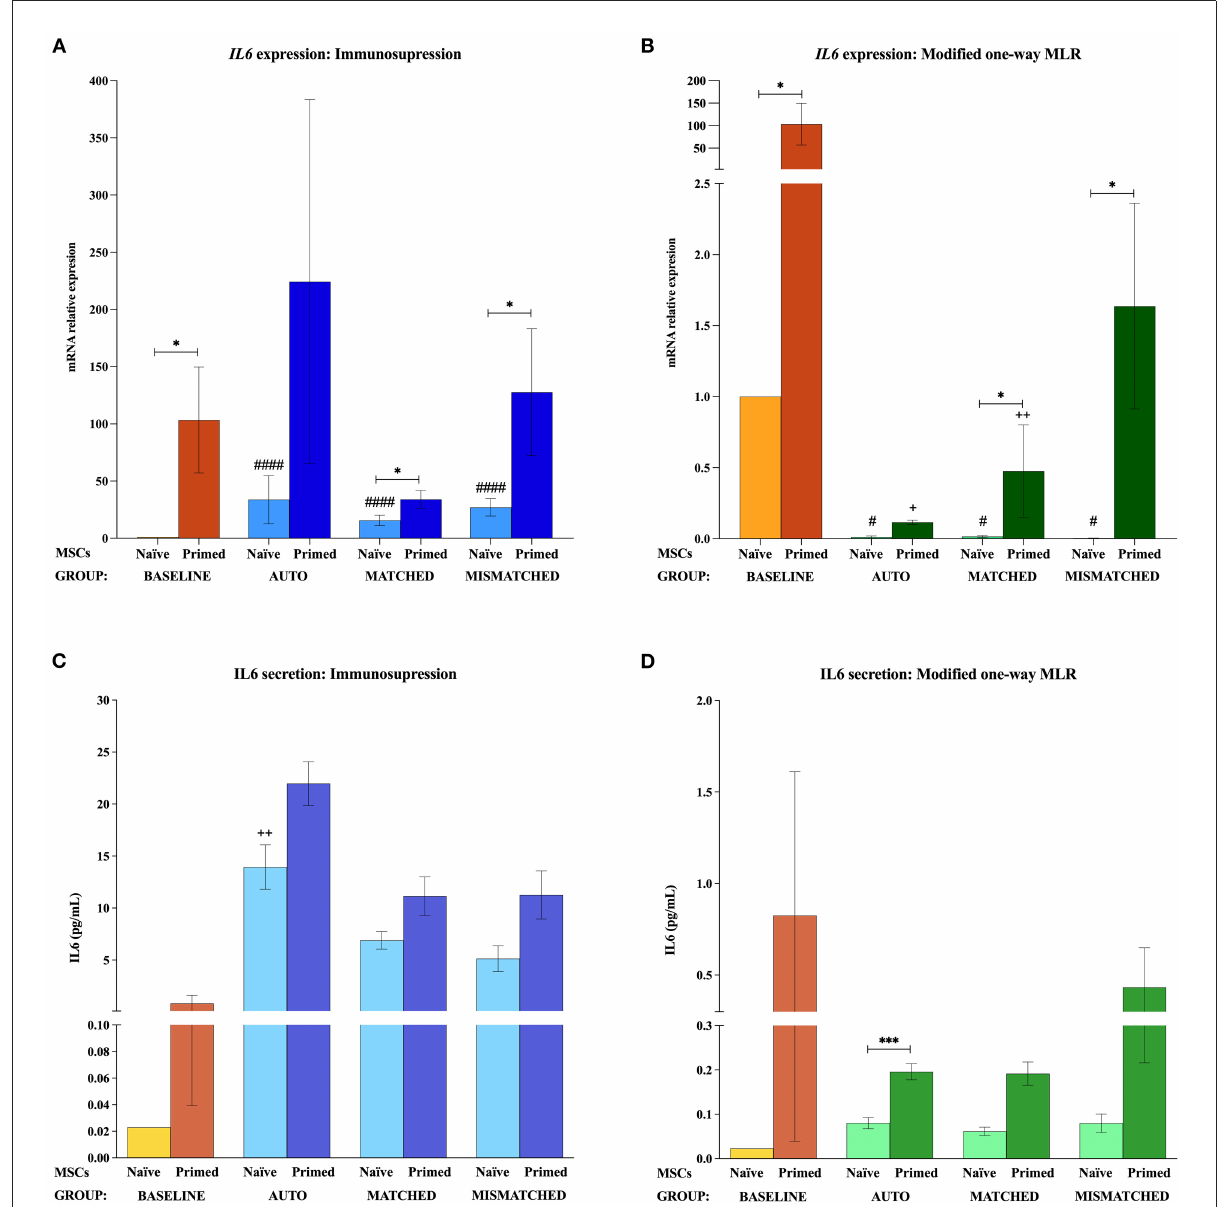
FIGURE2 Interleukin 6 (IL6) gene expression and secretion by equine mesenchymal stem cells (MSCs) in the different scenarios. (A) IL6 mRNA relative expression and (C) IL6 secretion (pg/mL) before (baseline; orange bars) and after equine MSC-naive (light blue bars) and MSC-primed (dark blue bars) were exposed in vitro to phytohemagglutinin (PHA)-activated peripheral blood lymphocytes (PBLs) (immunosuppression assays). (B) IL6 mRNA relative expression and (D) IL6 secretion before (baseline; orange bars) and after MSC-naive (light green bars) and MSC-primed (dark green bars) were exposed in vitro to resting PBLs [modified one-way mixed lymphocyte reaction (MLR) assays]. Co-cultures of MSCs and PBLs were autologous ( n = 3), allogeneic, matched ( n = 8), or mismatched ( n = 7) for the major histocompatibility complex. Changes in gene expression are represented as mean ± S.E.M of the relative mRNA expression, using baseline MSC-naive as reference sample (light orange bar, value 1). Concentration of IL6 in the supernatant from the different conditions is represented as mean ± S.E.M (pg/mL). Significant differences of each condition compared with the baseline MSC-naive (light orange bar) are represented by hashes (#) above the corresponding bar ( # p < 0.05; #### p < 0.0001). Significant differences compared with the baseline MSC-primed (dark orange bar) are represented by a cross ( + ) above the corresponding bar ( + p < 0.05; ++ p < 0.01). Significant differences between experimental conditions are represented by a squared line with an asterisk ( * p < 0.05; *** p <